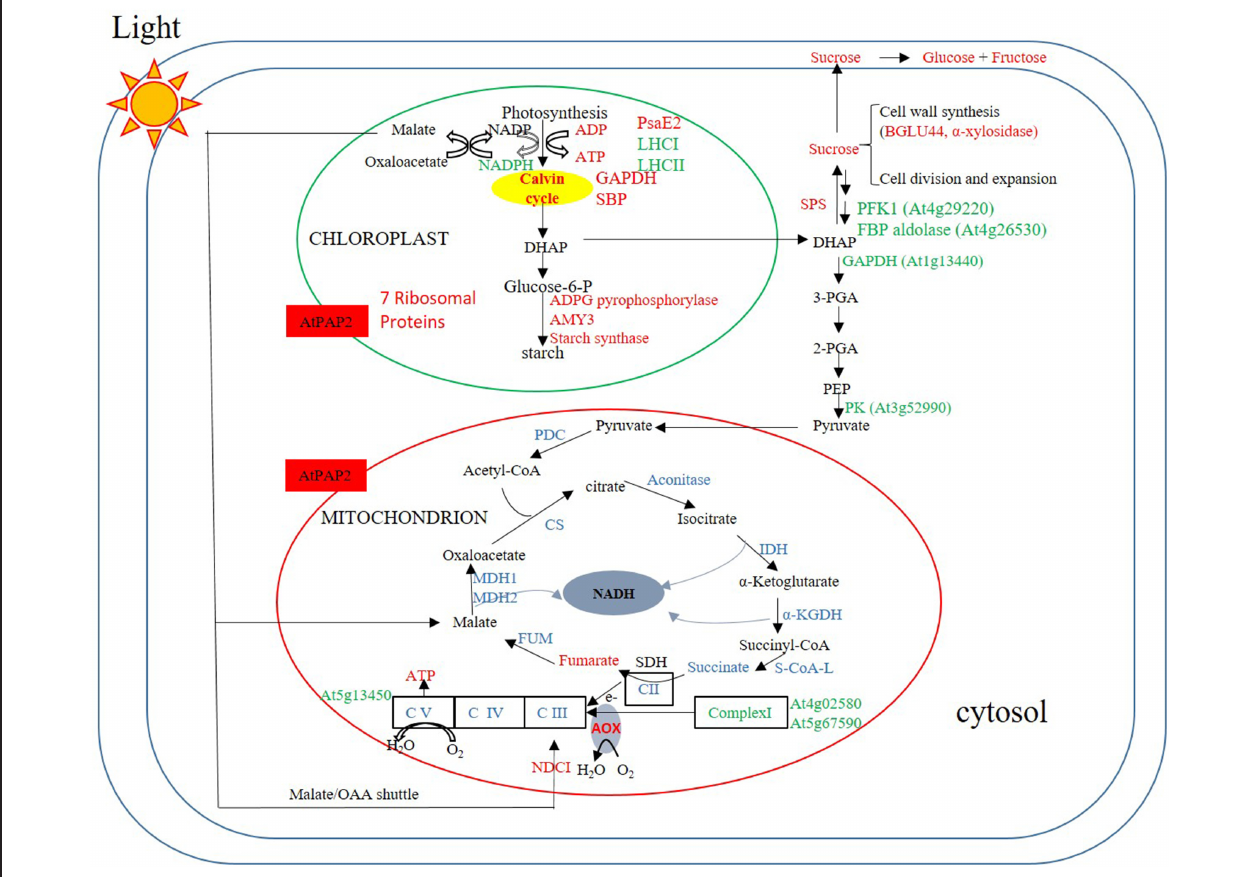
FIGURE 6 | Summary of protein and metabolites data at t = 8 h. Up-regulated proteins and metabolites in the OE line (vs WT) are indicated in red and down-regulated proteins and metabolites are indicated in green color. Undetected proteins and metabolites are indicated in black color. Proteins and metabolites without significant changes are shown in blue color. Under illumination, the abundances of some enzymes in the Calvin–Benson cycle, starch synthesis and sucrose synthesis were higher in the OE line, whereas the abundances of some enzymes in the glycolysis pathway and TCA cycle were lower or unaltered in the OE line. Regarding the respiratory complexes, some Complex I subunits exhibited lower protein abundances, but that of Complex II–V were generally